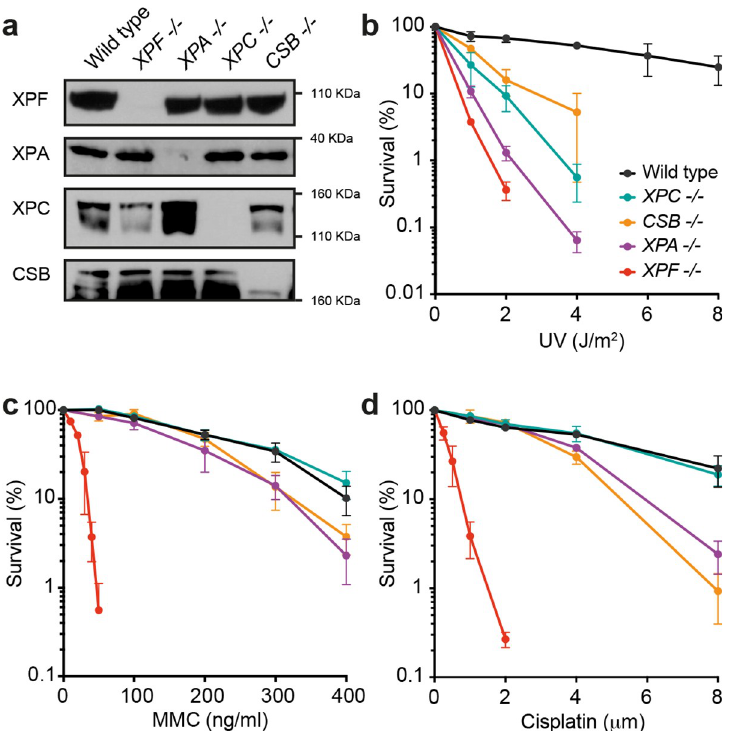
Fig 2. TC-NER confers protection against ICL-inducing agents. a) Western blots showing lack of NER proteins in HAP1 knock out lines. See S2 Fig for more details. b) Survival of HAP1 cells in response to UV light. c) Survival of HAP1 cells in response to mitomycin C (MMC). d) Survival of HAP1 cells in response to cisplatin. In b-d , each data point represents the mean of at least two independent experiments, each carried out in duplicate, error bars represent